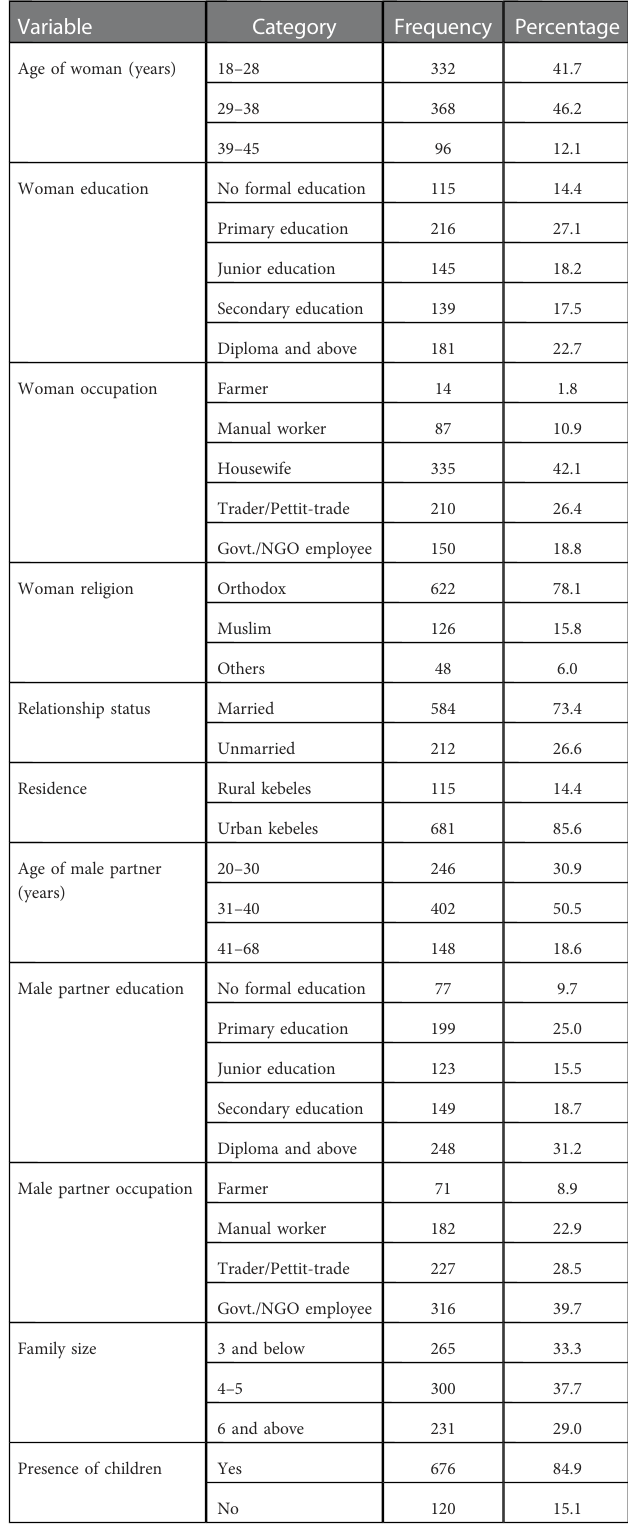
TABLE 3 Sociodemographic characteristics of the study participant women and their male partners and families in Debre Berhan, Ethiopia, 2021 ( n